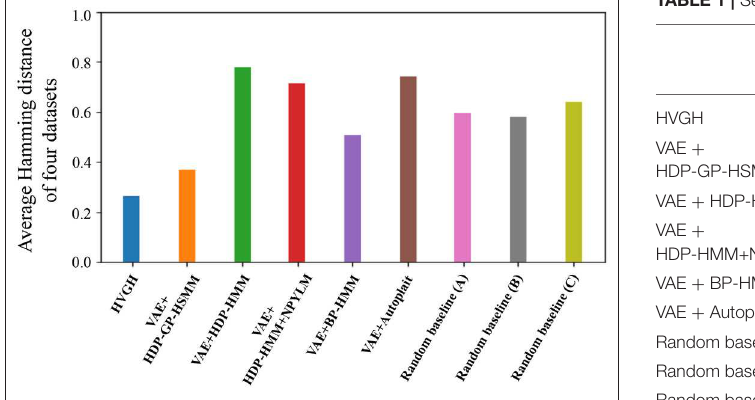
TABLE 1 | Segmentation results for the chicken dance.